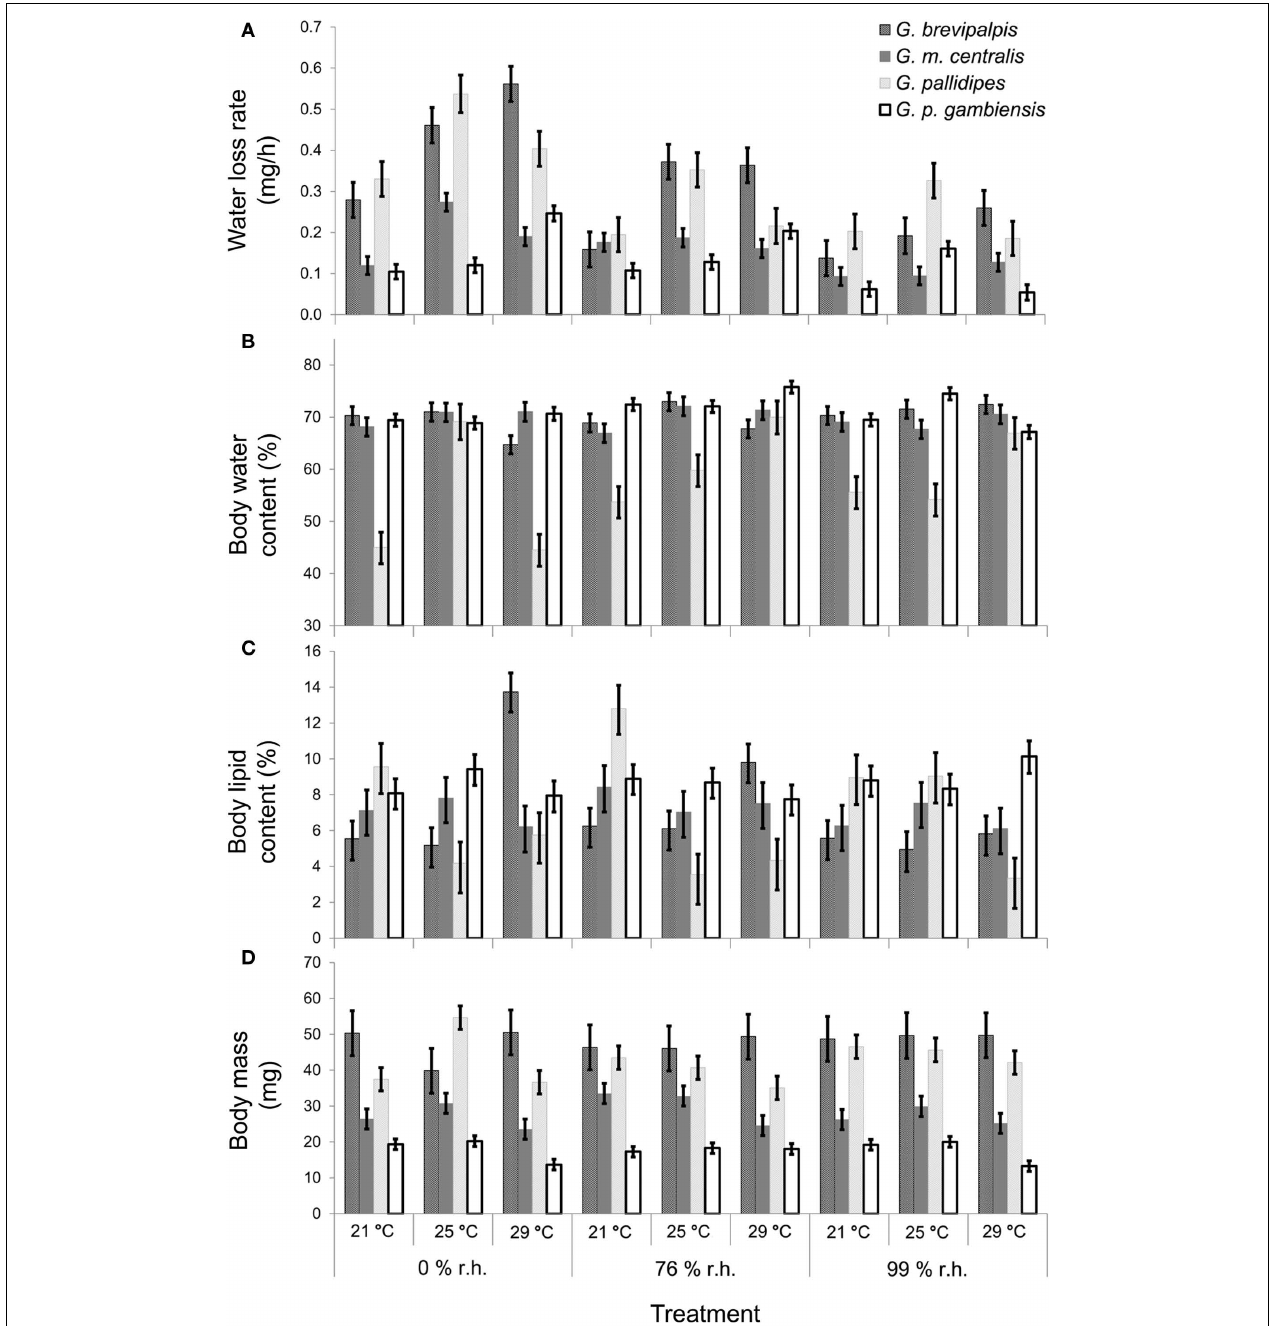
content (as a % of initial body mass), (C) body lipid content (as a % of initial body mass), and (D) initial body mass (in mg) .Water balance traits were measured at three different relative humidities and three different